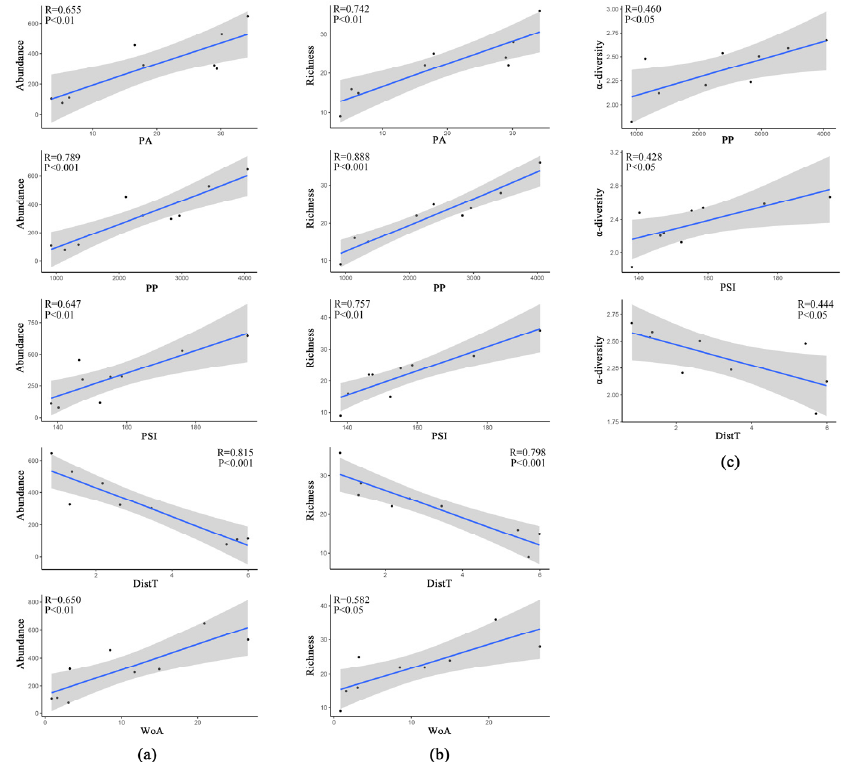
Figure 7. Pearson correlation of landscape features and bird diversity indicators. ( a – c ) are the relationships between landscape features and the overall bird species abundance, richness, and α -diversity, respectively.